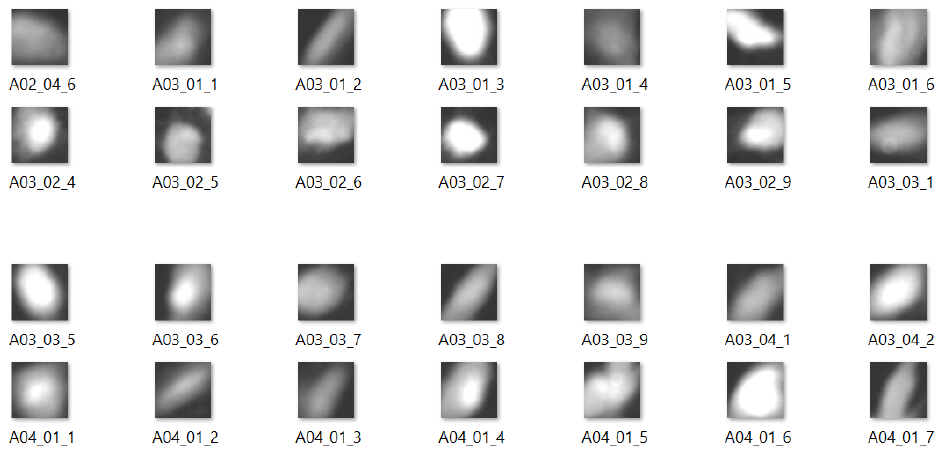
Figure 8. Sample images in the preprocessed